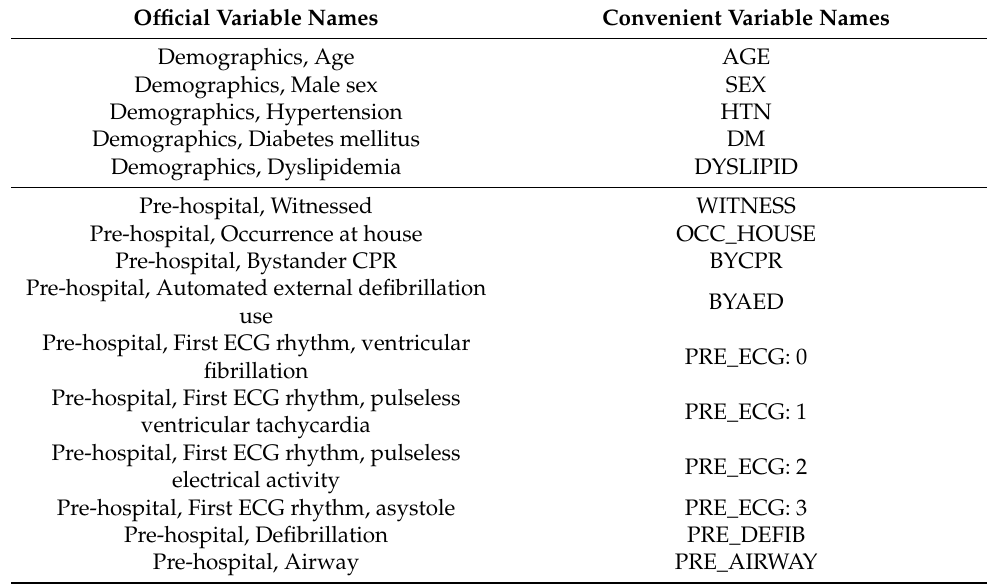
Table A1. Convenient variable names corresponding to the official variable